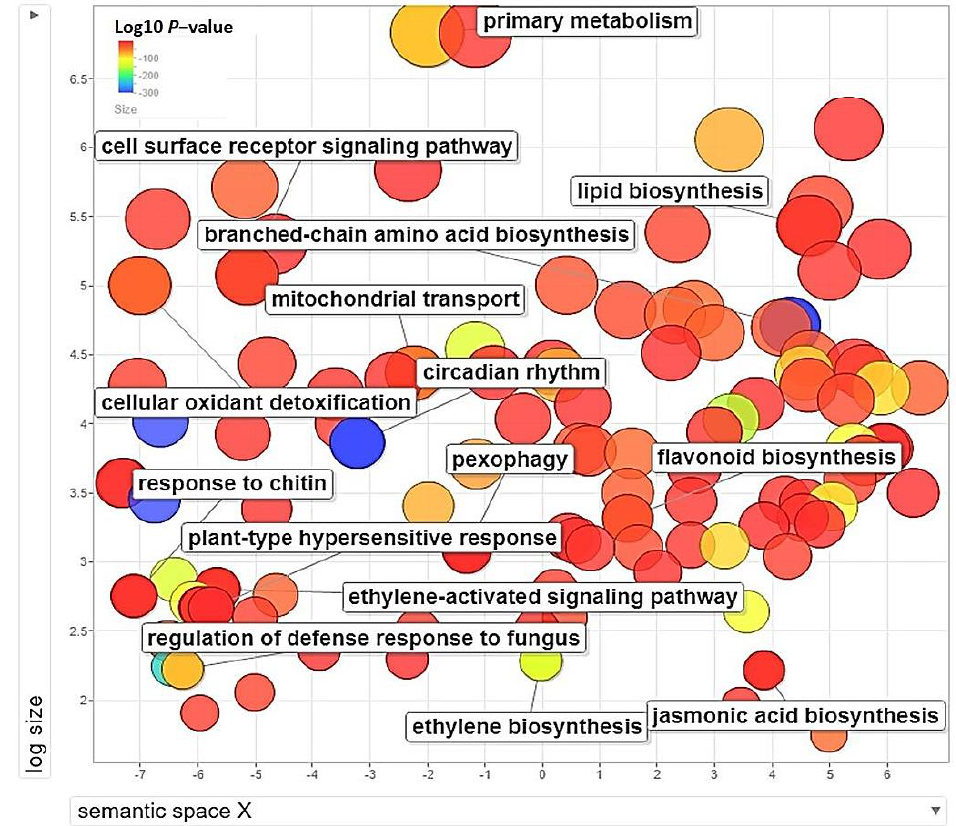
Figure 3. Scatterplot showing the over-represented GO term ( p < 0.01) in all comparisons with labels on the disease responsive terms. Different shades in circles indicate the difference in p -values (as given in the scale) whereas the bubble size indicates the frequency of the GO term.